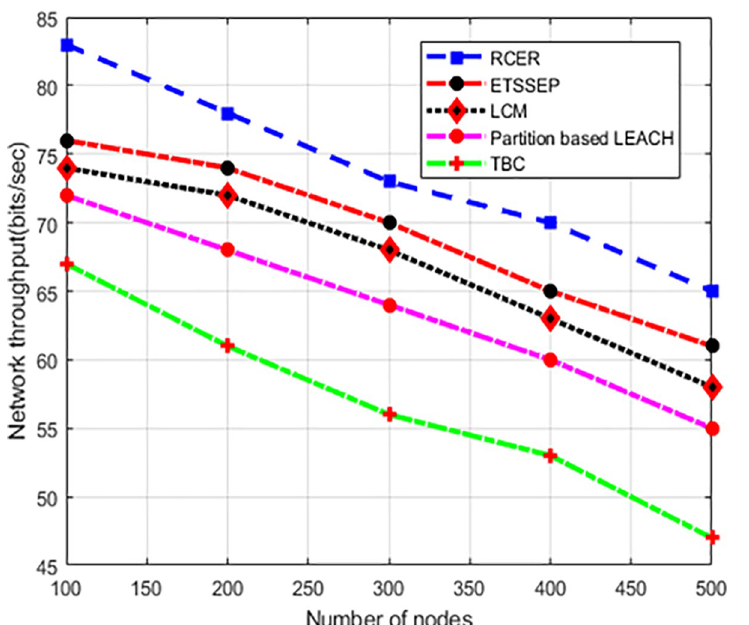
Fig 12. Network throughput in high-density nodes.